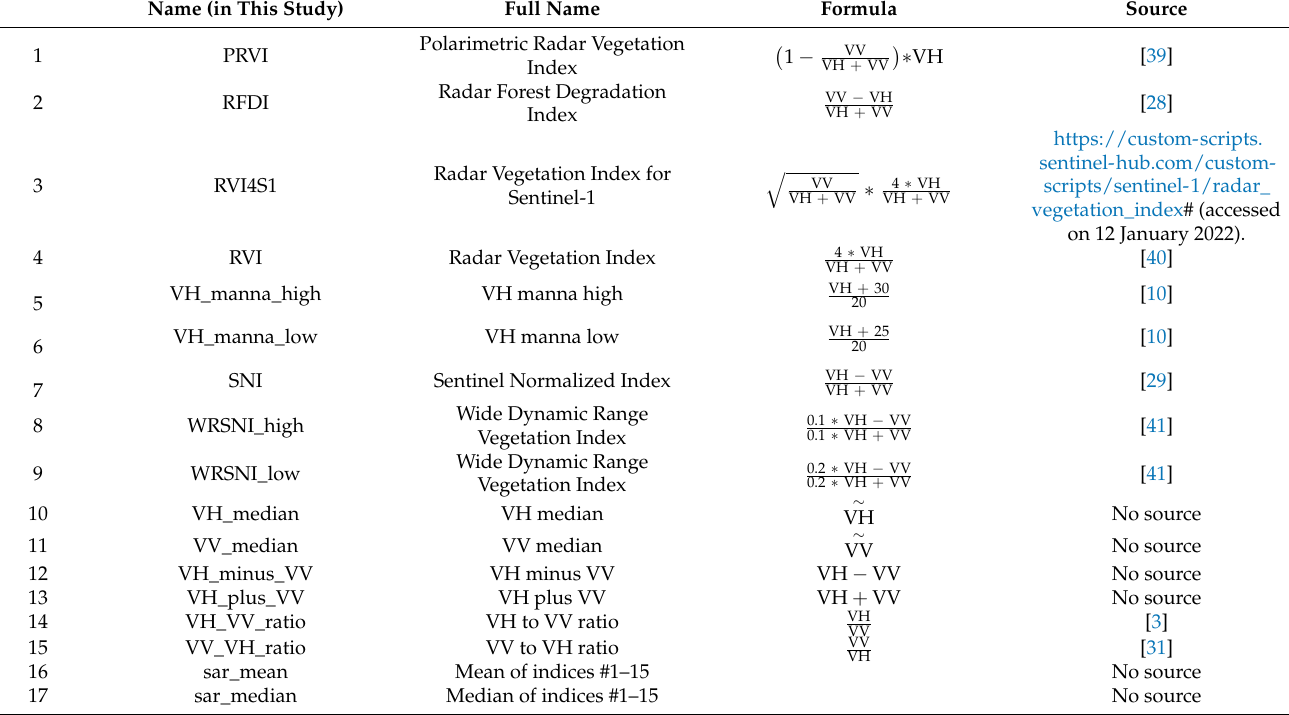
Table 2. The SAR indices that were used in this study as the input for the random forest model. The source might contain a formula used to inspire the formula mentioned here. Note that some indices were not developed to estimate the NDVI directly; rather they are related to other crop parameters and hence may contribute to the SNAF